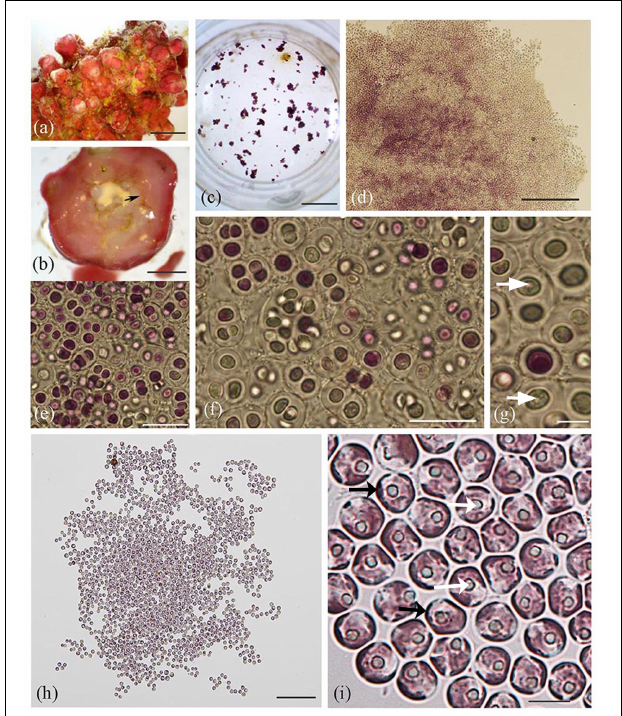
FIGURE 1 | Lithothamnion sp. rhodolith collected from Ewing Bank, northwestern Gulf of Mexico, and light microscopy images of Rhodosorus marinus cells. (a) Surface view of habit of Lithothamnion (LAF6573b); (b) cross section through rhodolith protuberance displaying internal area where endolithic Rhodosorus cells were found (arrow); (c) culture well plate viewed under dissecting scope, with cultured Rhodosorus cells and Ochrosphaera haptophyte cells (brown clusters); (d) magnified view of cell clusters seen in Figure 3c ); (e–g) light micrographs of single cells or cell clusters (in pairs, tetrads, or up to 12 cells). Cell division by concavo-convex division resulted in hemispherical cells subsequently expanding in size, each with a prominent central pyrenoid (white arrows); (h) Rhodosorus subculture; (i) close-up of cells shown in (3 h) showing parietal chloroplast lobes (black arrows) and pyrenoid (white arrows). Scale bars: (a) = 0.5 mm, (b) = 2 mm, (c) = 15.5 mm, (d) = 200 µ m, (e) = 20 µ m, (f) = 20 µ m, (g) = 5 µ m, (h) = 150 µ m, (i) = 6 µ